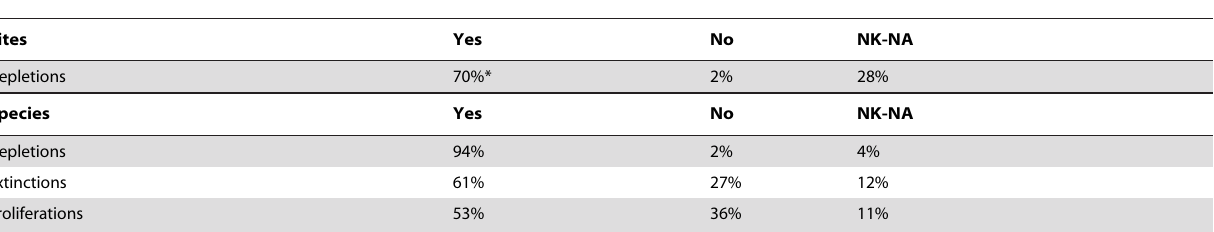
Table 1. Summary of answers from fishers’ interviews.